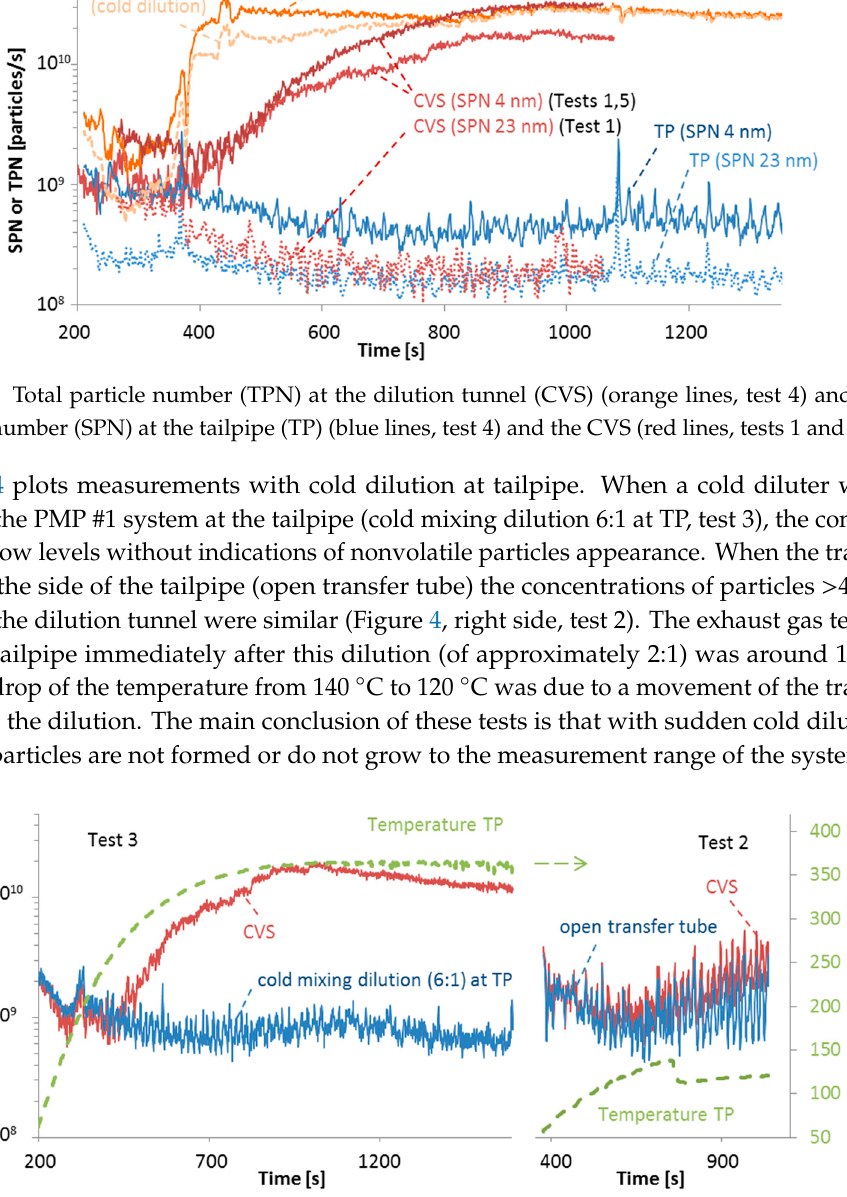
Figure 4. Solid particle number (SPN) emission rates for particles > 4 nm at the tailpipe (TP) and the dilution tunnel (CVS) with different configurations. The temperature at position 1 (TP) is also plotted.